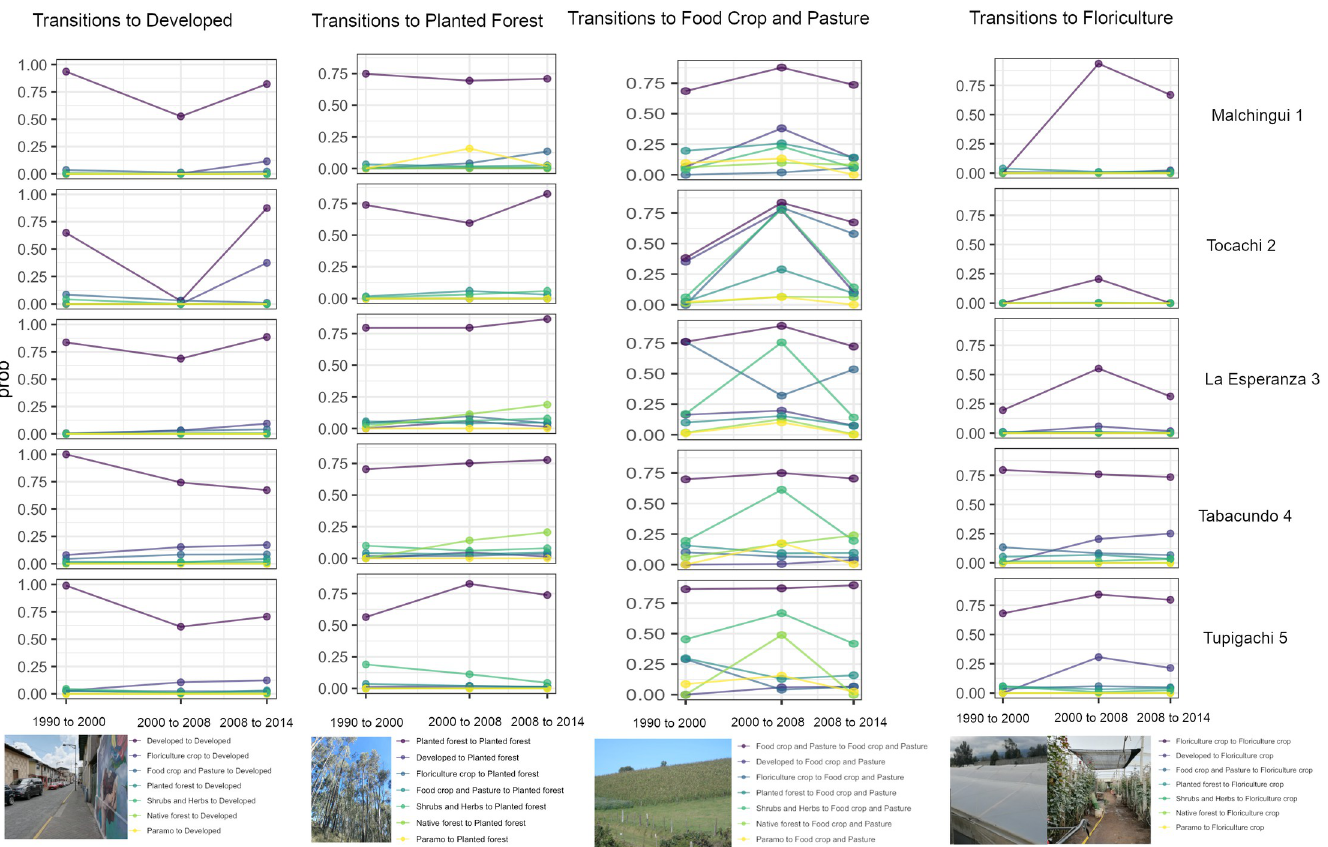
Fig 6. Probability of land use transition to anthropic environments in Pedro Moncayo county, at the parish level through time. The above photos depicting the developed area and the floriculture crops are reprinted from Guasgua (https://zenodo.org/record/6231701#.YhVzVpPMLJ8) under a CC BY license, with permission from (Jessica Guasgua), original copyright 2022. The other photos are the original works of the authors.